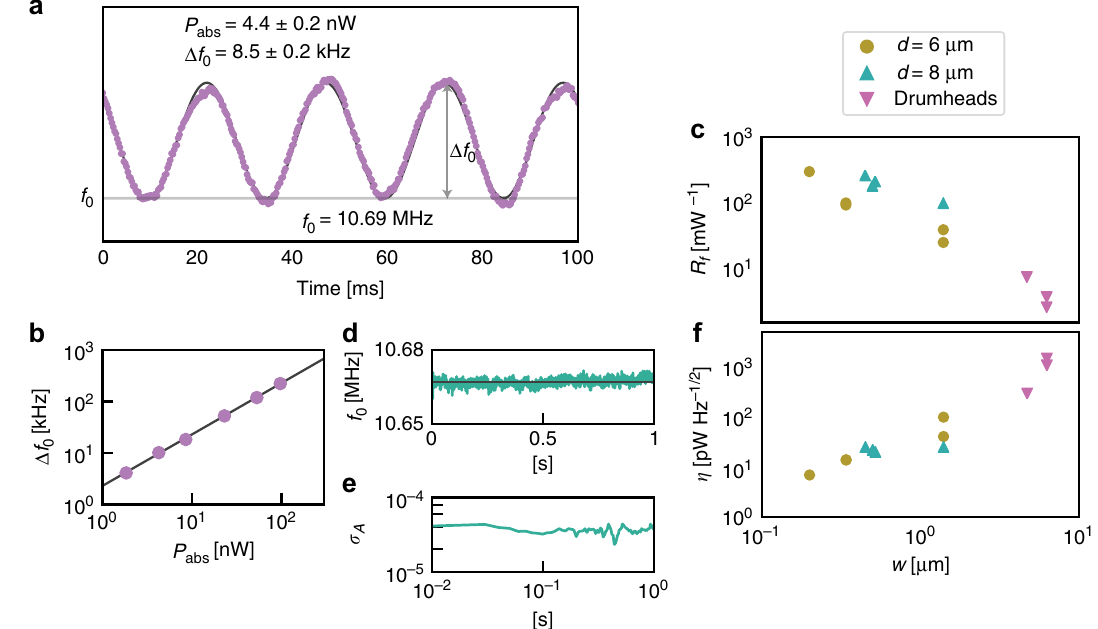
Fig. 2 Frequency responsivity to absorbed light and frequency noise measurements of graphene resonators. a Mechanical resonance frequency vs. time for a 8 µ m diameter trampoline with 500 nm wide tethers. The device is subject to 190 nW of incident radiation modulated at 40 Hz. Assuming 2.3% ¼ 4 : 4 nW, which causes a frequency shift of Δ f = 8.5 kHz. b Measured resonance shift vs. absorbed power. A absorption, the absorbed power is P 0 abs best- fi t line to this data yields a 2.3 kHz nW − 1 resonance shift per incident power. c Frequency responsivity, R f , vs. tether width, w , for nine different trampolines and three different drumheads. For the drumheads, the tether width is taken to be 1/4 of the drumhead circumference. d Resonance frequency vs. time for a trampoline GNB device. The device is not exposed with heating laser light other than that needed for the measurement. e Allan deviation, σ A , of the frequency noise vs. measurement time in a log – log plot. The resonance frequency was tracked with the PLL to obtain temporal frequency data. f Sensitivity, η , vs. tether width for nine different trampolines and three different drumheads. Symbol legend is shared between c and f . Circles indicate a trampoline with a 6 µ m diameter, turquoise triangles indicate a trampoline with an 8 µ m diameter, and magenta triangles indicate a drumhead resonator of either 6 or 8 µ m diameter. Source data are provided as a Source Data fi